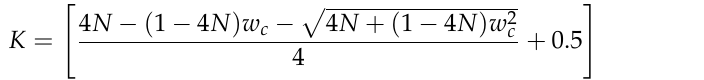
Figure 5. Accuracy comparison of Equations (15) and (28) due to 𝑁 for ( a ) 𝑤 𝑐 = 0.4 ( 𝜔 𝑐 = 0.369𝜋 ) and ( b ) 𝑤 𝑐 = 0.7071 ( 𝜔 𝑐 = 0.25𝜋 ).